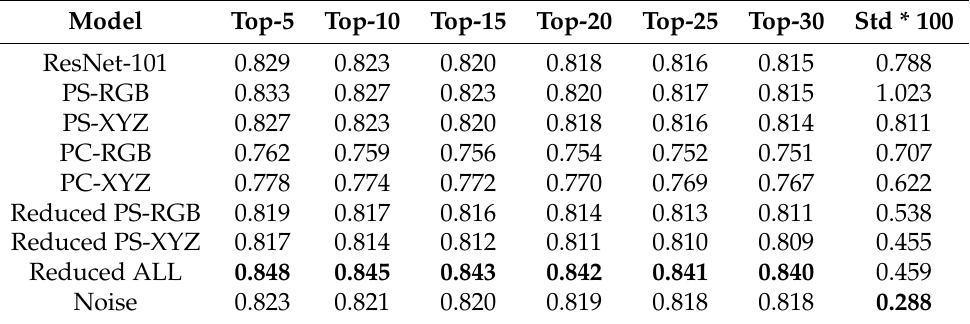
Figure 7. The mean accuracy curves for the Models ResNet-101, PS-RGB, and Reduced ALL over the course of the training process. There are 100 training epochs in total. The mean accuracy on the testing set is balanced. ( a ) Validation dataset; ( b ) testing dataset. Table 2. The Top 5,10,15,20,25, and 30 balanced accuracies of all models. The Std column tabulates the standard deviations of the Top 30 accuracies. Values with bold denote the best in correspond- ing